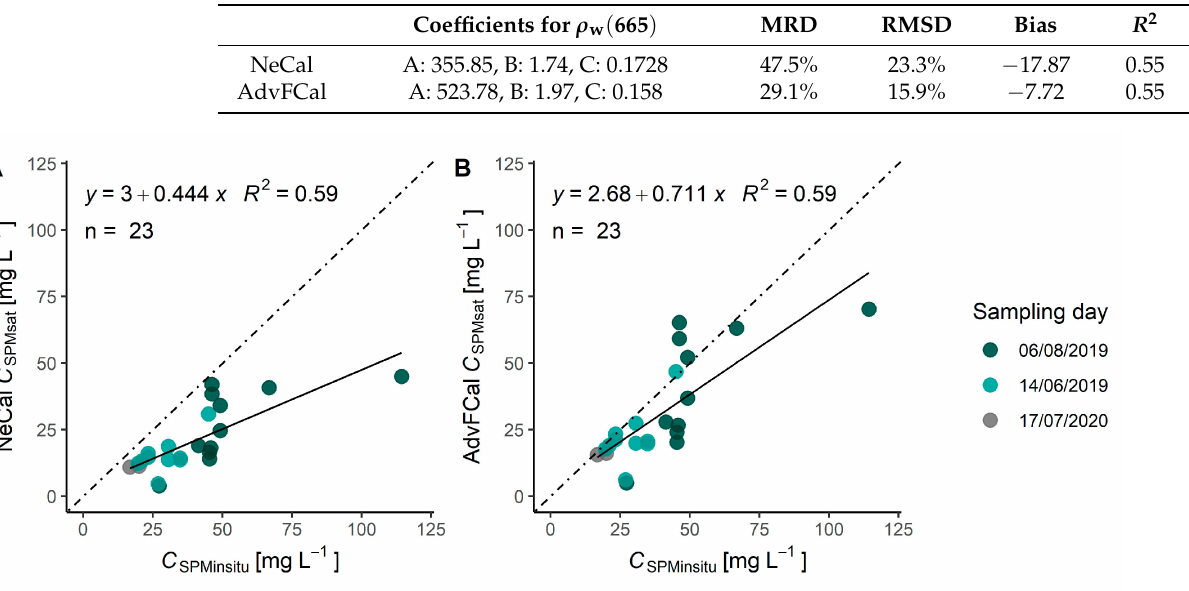
Table 3. Coefficients for the SPM-algorithm in the original (NeCal) [41] and the adapted regional (AdvFCal) calibration. Measures of accuracy are given with mean relative difference (MRD), root mean square difference (RMSD), bias, and the coefficient of determination ( R 2 ).